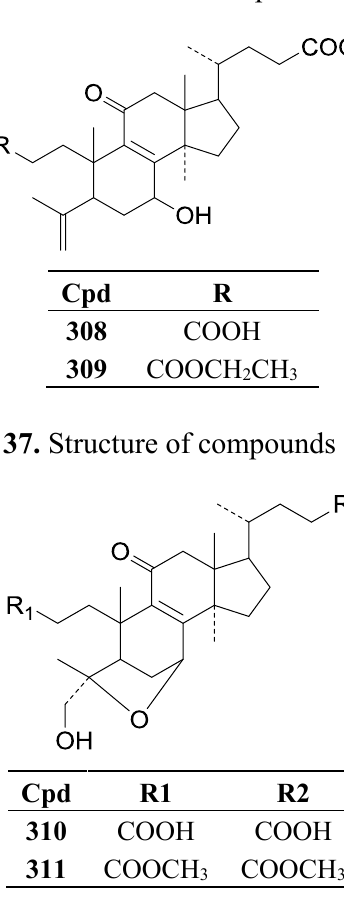
Figure 36. Structures of compounds 308 – 309 .